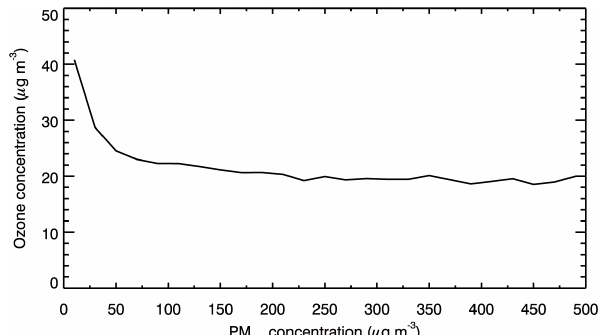
Figure 3. Average O 3 mass concentrations over monitoring sites in GZB as a function of the PM 2 . 5 mass concentration during the wintertime from 2013 to